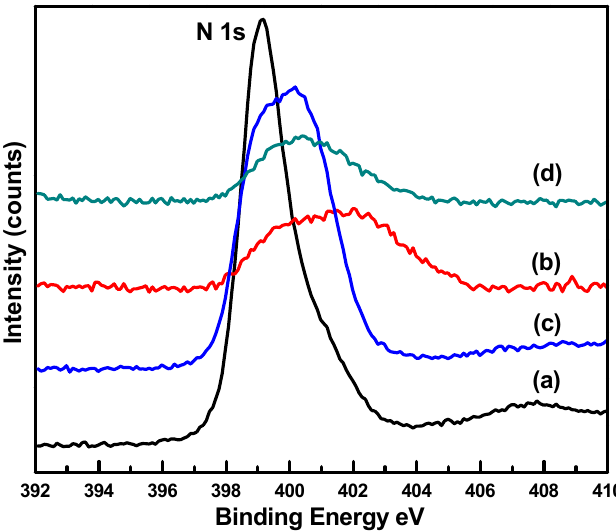
Figure 4. XPS N 1s spectra of ( a ) CuIm ( b ) CuZrIm0.5 ( c ) CuZrIm1 ( d ) CuZrIm1.5 .